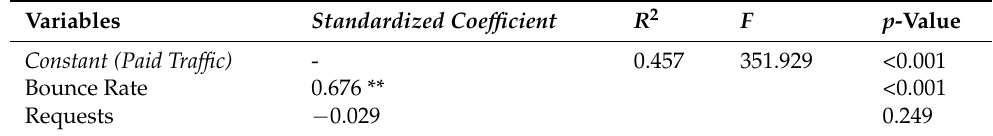
Table 8. Third hypothesis’ Regression.